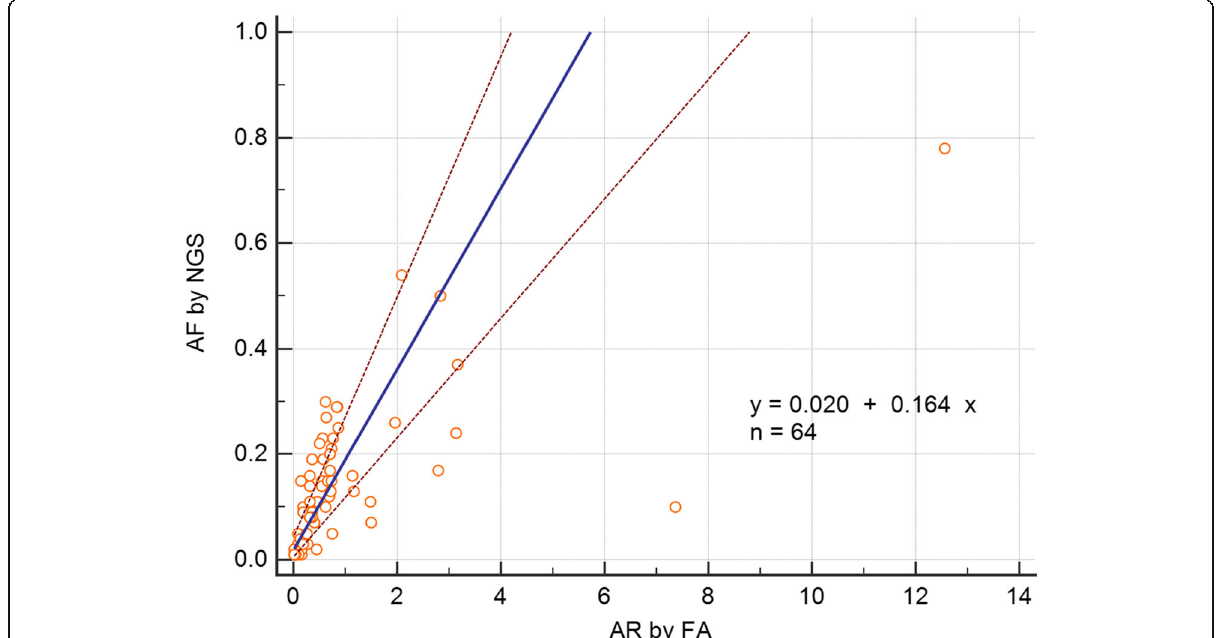
Fig. 1 Correlation of the FLT3 ITD mutant burden as assessed by the two study methods; Allelic ratio (AR) values from fragment analysis and allele frequency (AF) values from NGS are indicated, respectively. Abbreviations: AF, allelic frequency; NGS, next generation sequencing; AR, allelic ratio; FA, fragment analysis